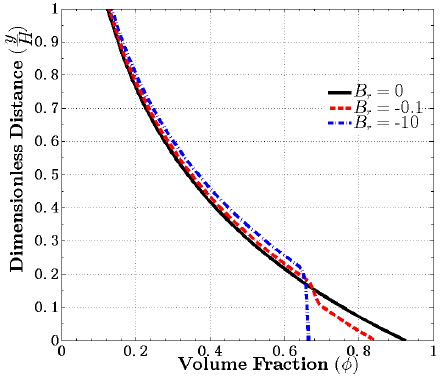
Figure 2. The effect of 𝐵 (cid:3045) on the volume fraction profile, when 𝑅 = 1 , 𝑚 = 1 , (2𝑀 (cid:2869) + 𝑀 (cid:2870) ) = 1 , 𝐵 (cid:3043) = −1 , 𝜙 (cid:3030) = 0.68 , 𝑆 = 100 , 𝐹𝑟 = 0.5 , 𝑁 = 0.4 .